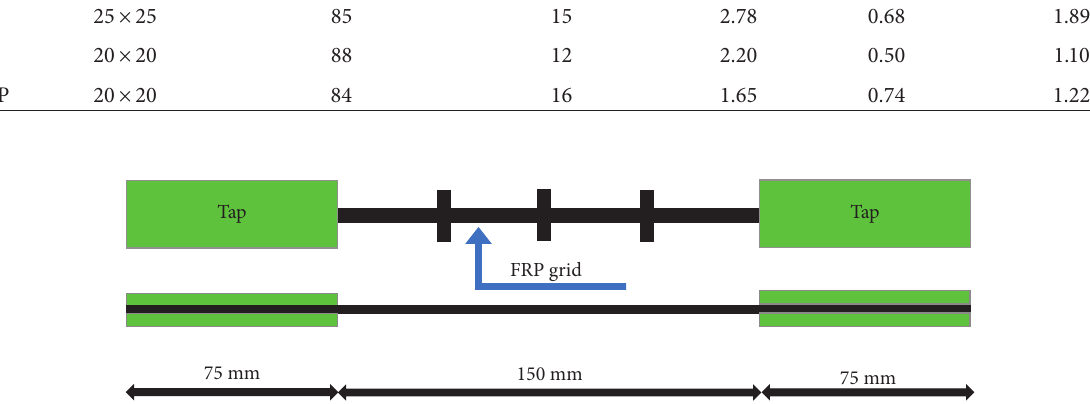
Figure 2: Schematic detailing of the FRP grid for tensile tests.